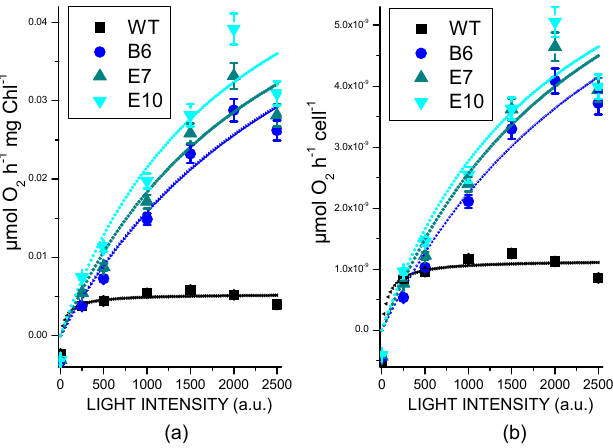
Figure 5. Light saturation curves of photosynthetic oxygen evolution obtained from WT (4A+) and transformed lines. Data are reported on chlorophyll basis ( a ) or on a cell basis ( b ). Standard deviations are reported as error bars ( n = 3).